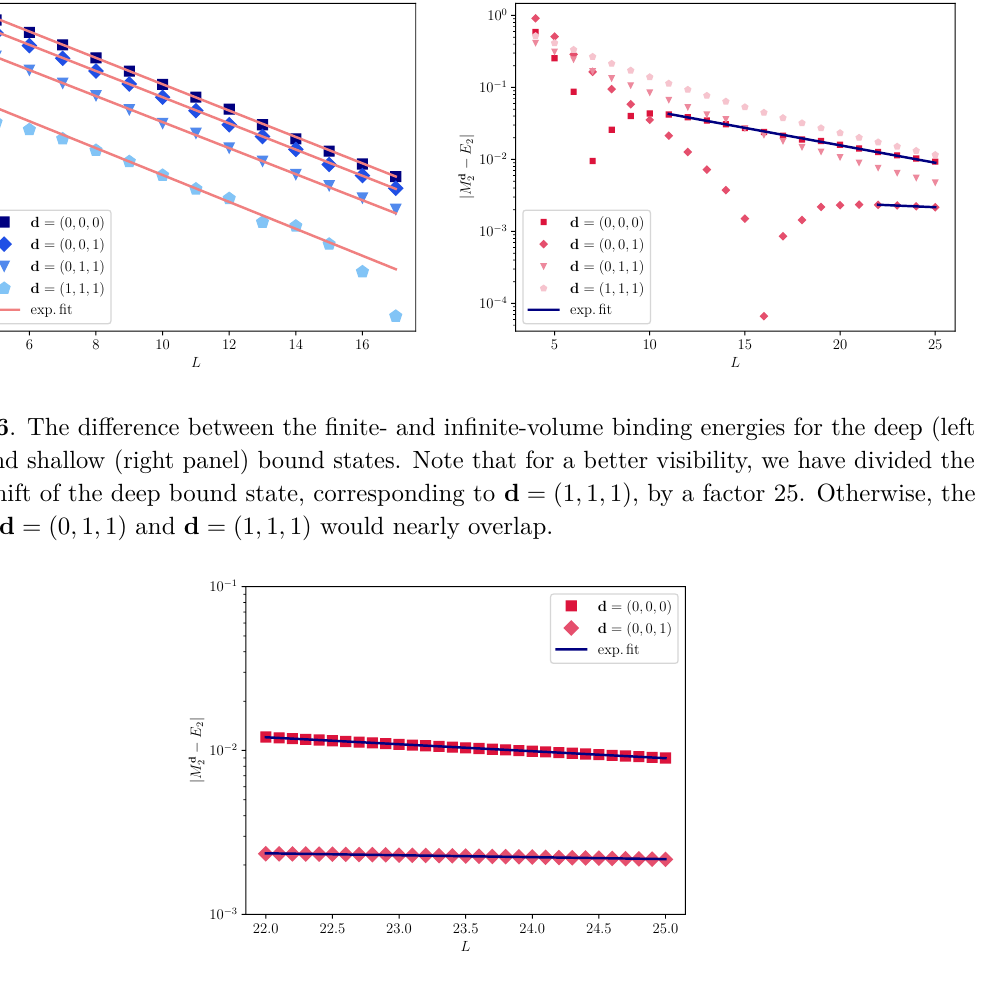
Figure 7 . The differences between the finite- and infinite-volume binding energies for the shallow bound state at larger values of L . The straight lines show the results of the exponential